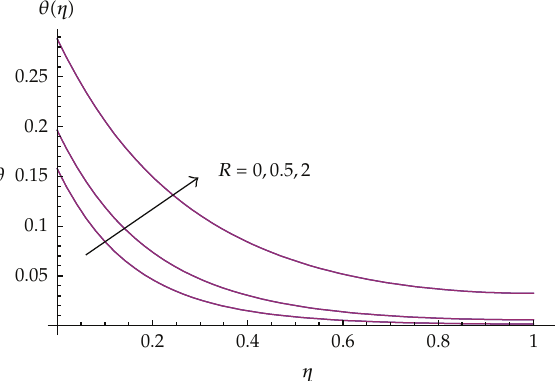
Figure 5: The behavior of the temperature distribution for various values of R with S (cid:7) 0 . 8, Pr (cid:7) 3, and B ∗ (cid:7) 0 .